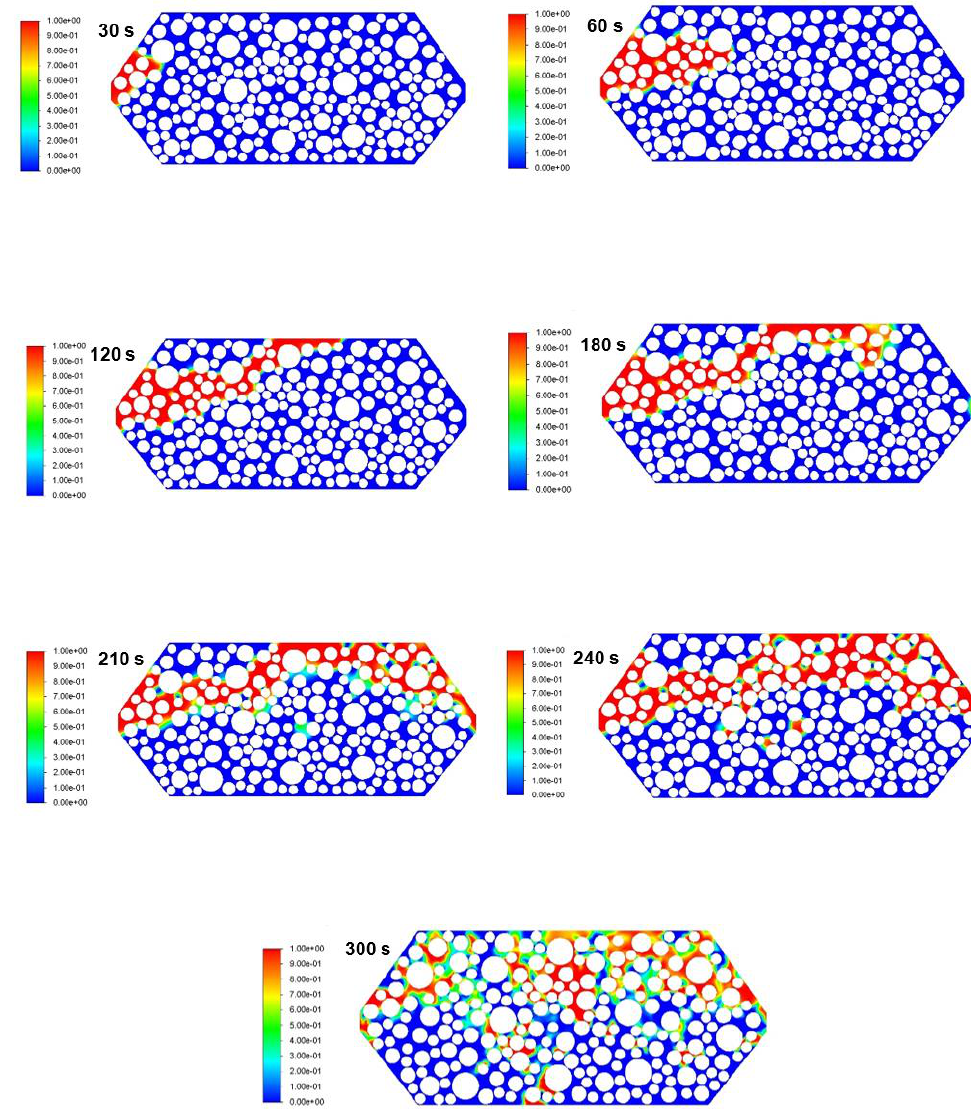
Figure 9. Volume fraction of oil displaced (blue) at different times by injected APG (red) for case 1.